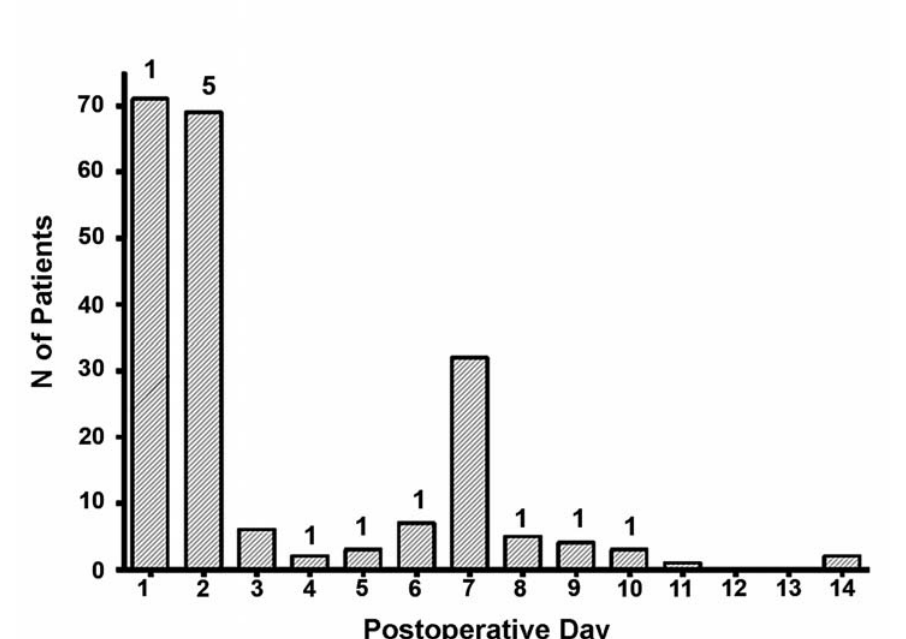
Figure 1 – Distribution of cystogram based on postoperative day performed. Leaks are indicated as numbers above bar